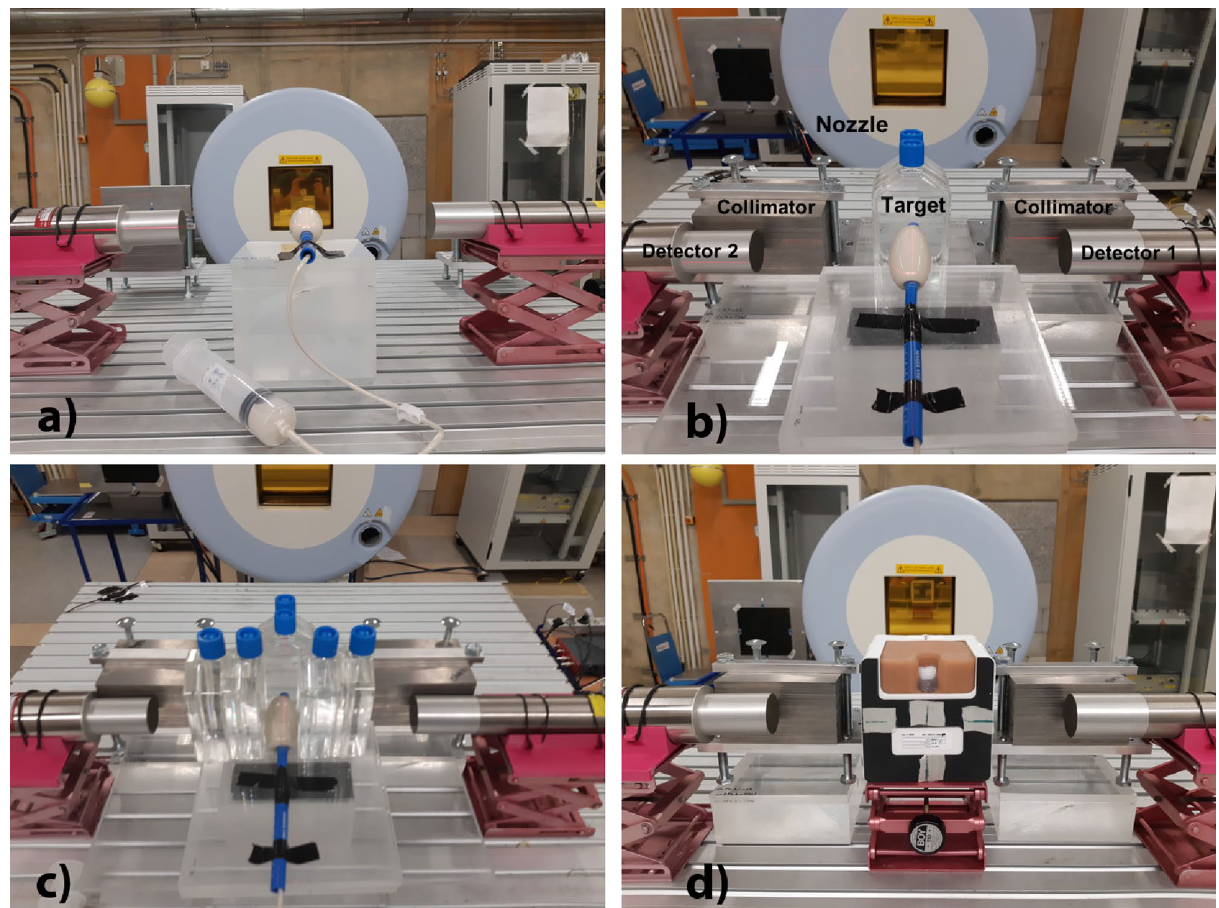
Figure 1. Experimental setup. ( a ) Photo of the experimental setup, consisting of an irradiating nozzle, a target, and two CeBr 3 detectors. ( b ) Photo of a similar setup with the target placed behind two flasks of water in the beam path. ( c ) That with two flasks of water placed on each side of the target. Two tungsten collimators were placed in front of each detector in the beam direction. ( d ) Photo of the same setup with the target of a prostate phantom with a commercial silicone